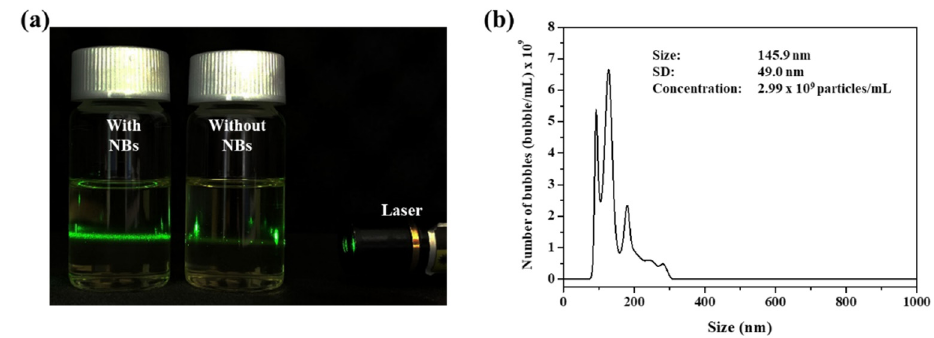
Figure 1. ( a ) Photograph image of NB oil and pure NBs in the presence of green laser irradiation. ( b ) NTA data of generated NB oil.